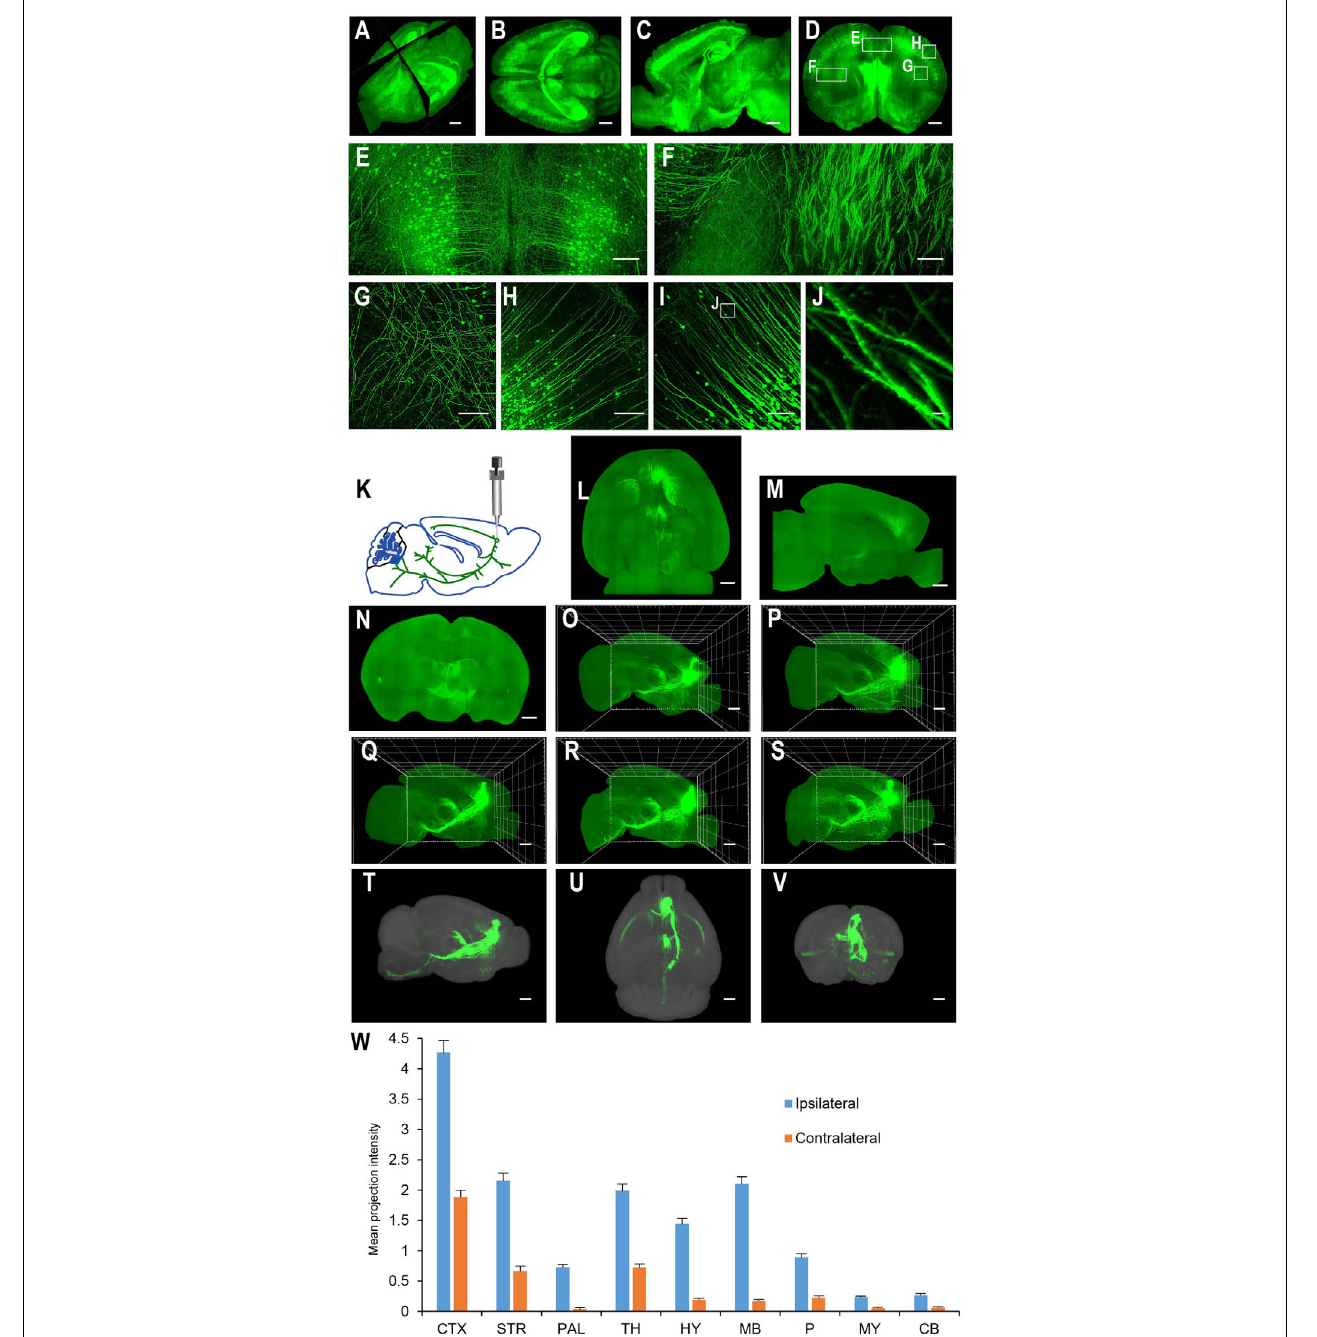
FIGURE 4 | Whole brain imaging of CUBIC-X-cleared Thy1-YFP-H transgenic mouse brains and EGFP virus injected brains. (A) Low resolution rendering of a Thy1-YFP-H transgenic mouse brain. The brain was CUBIC-X-cleared. Similar results were observed in four samples. (B) Maximum intensity projection (MIP) of a representative horizontal section of the brain in (A) . (C) MIP of a sagittal section at position indicated in (A) . (D) MIP of a coronal section at position indicated in (A) . (E–H) Enlarged view of the boxed regions in (D) . (I) MIP of a representative coronal section showing apical dendrites of cortical neurons. (J) Enlarged view of the boxed region in (I) showing dendritic spines. (K–W) Whole brain imaging of bulk-injected brain reveals axonal projections of medial prefrontal cortex (mPFC) neurons in different cortical and subcortical areas. (K) Anterograde tracing virus (AAV2/1-CAG-tdTomato) is injected in mPFC (AP 1.85, ML 0.4, DV 1.7). (L–N) Horizontal, sagittal, and coronal MIPs of a CUBIC-X-cleared brain showing projections of mPFC population neurons. Similar results in n = 5 samples. (O–S) Sagittal MIPs of five different brains showing similar projection patterns. (T–V) Averaged sagittal, horizontal, and coronal MIPs. (W) Mean projection intensity approximated by gray value in the ipsilateral and contralateral hemispheres relative to the injection site. CTX, cerebral cortex; STR, striatum; PAL, pallidum; TH, thalamus; HY, hypothalamus; MB, midbrain; P, pons; MY, medulla; CB, cerebellum; M2, secondary motor area; VAL, ventral anterior-lateral complex of the thalamus; VM, ventral media nucleus of the thalamus; MD, mediodorsal nucleus of thalamus; CM, central medial nucleus of the thalamus; PO, posterior complex of the thalamus. Scale bars, 1 mm (A–D,L–V) , 200 µ m (E–H) , 100 µ m (I) , 5 µ m (J) .